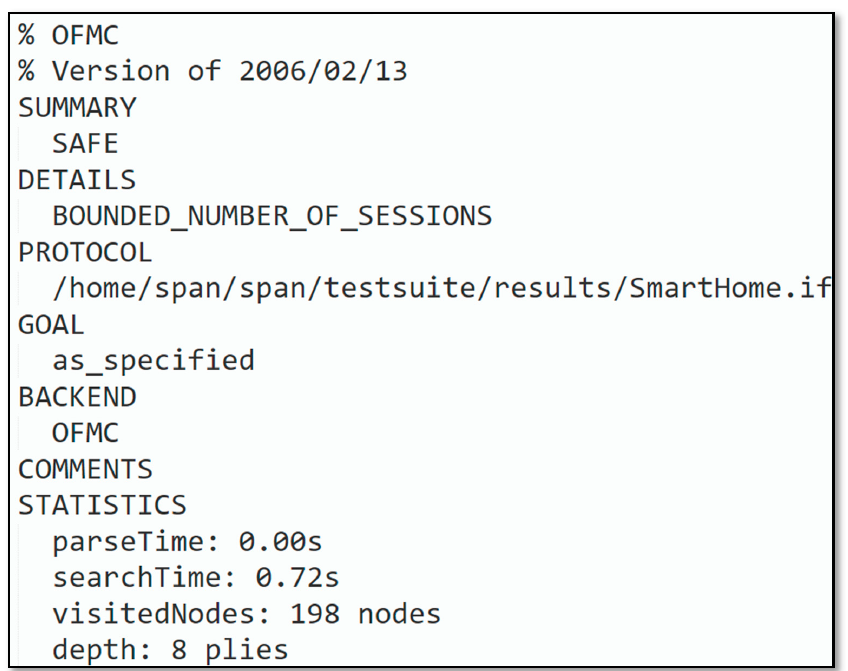
Figure 8. OFMC backend